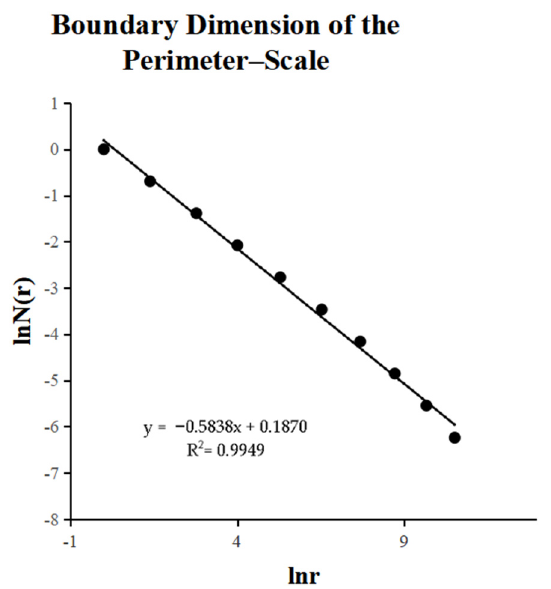
Figure 5. Bilogarithm diagram of boundary dimension estimated by circumference–scale model for Block 15.